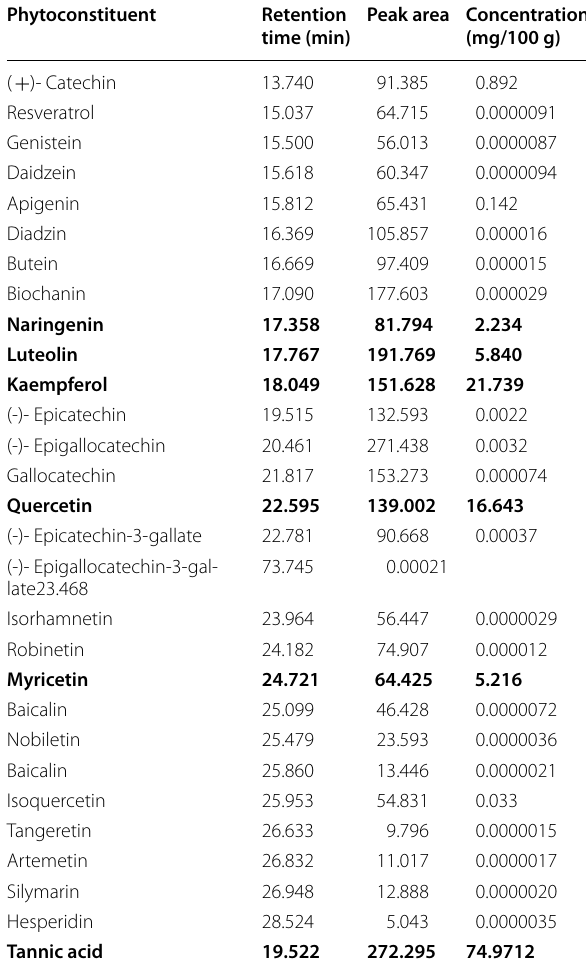
Table 9 Phytochemical components identified by GC-FID in the most active (ethyl acetate) fraction from leaf extract of C. albidum Phytoconstituent